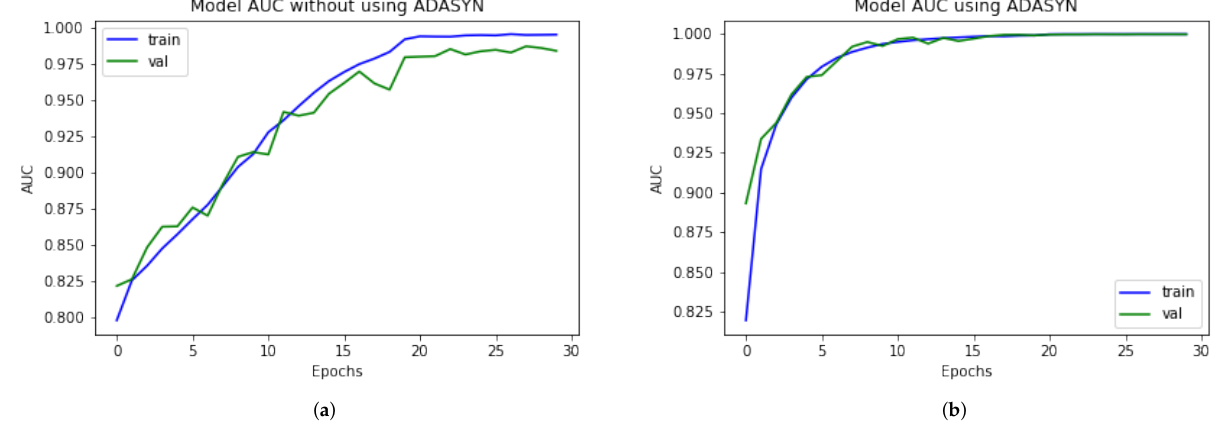
Figure 9. Self-comparison of AUC of proposed DAD-Net With and without using ADASYN up- sampling algorithm. ( a ) Proposed DAD-Net without ADASYN; ( b ) Proposed DAD-Net with